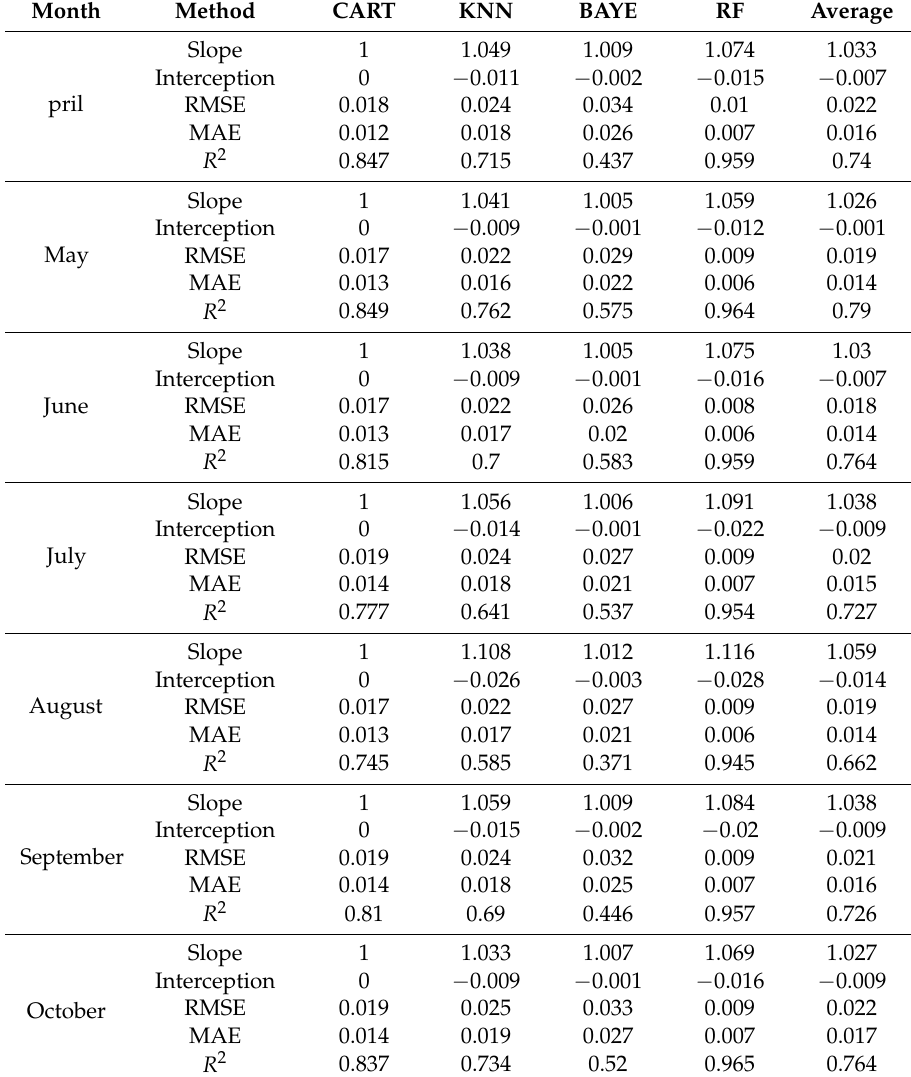
Table 2. Monthly slope, interception, RMSE, MAE and R 2 between ESA CCI SM and the four algorithms regressed